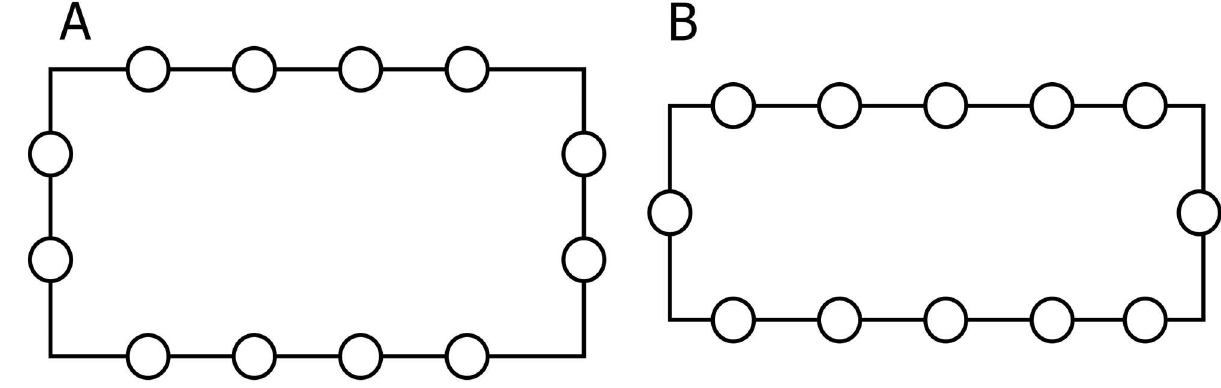
Fig 7. Final part of the lesson.